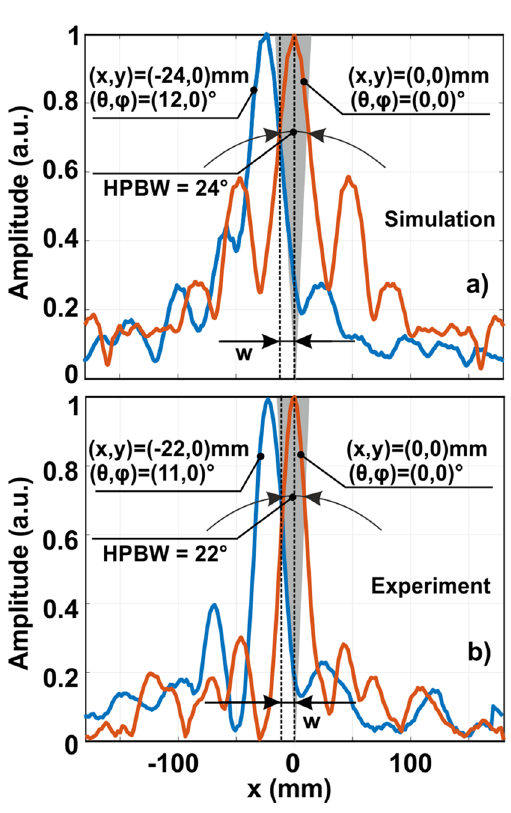
Figure 7. Angular accuracy—( a ) numerical and ( b ) experimental electric field amplitude distributions for different locations of a source indicated in the